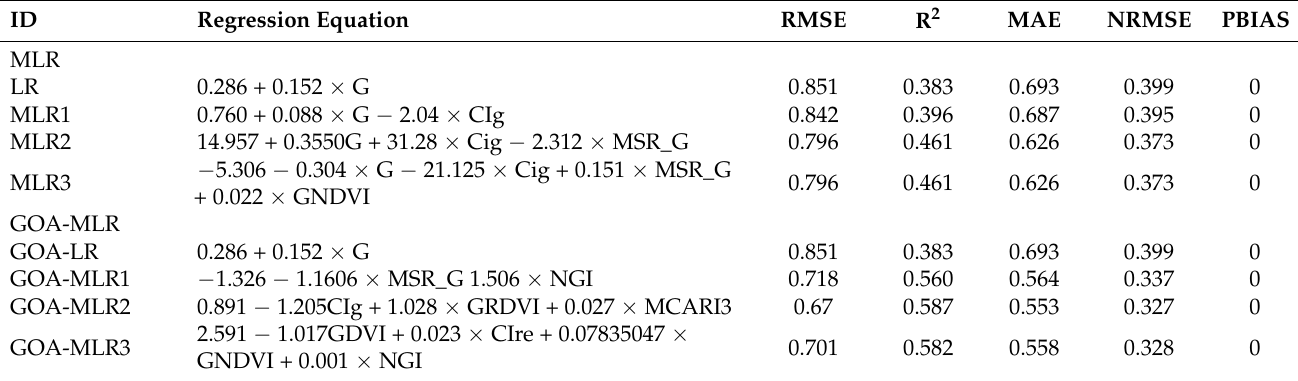
Table 4. Stepwise MLR models and